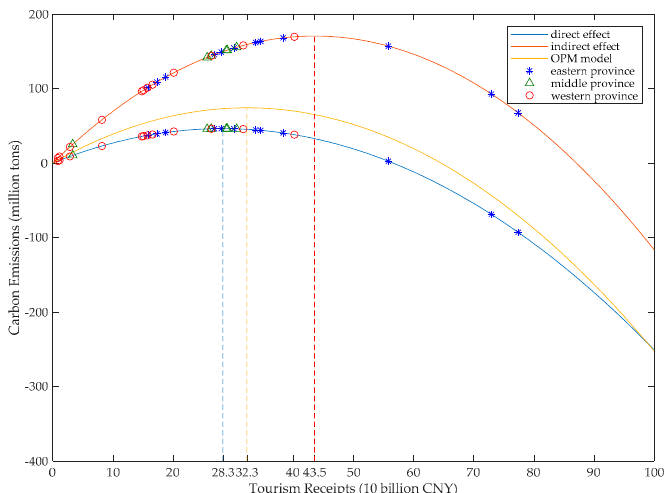
Figure 2. The nonlinear direct and indirect effects of tourism on carbon emissions.